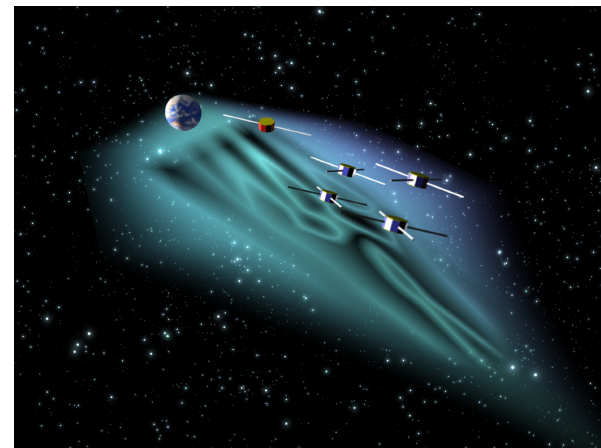
Figure 9. Sketch of magnetotail surface waves extended along the tail and propagating from 3 Fig. 9. Sketch of magnetotail surface waves extended along the tail the centre to the flanks. 4 and propagating from the centre to the